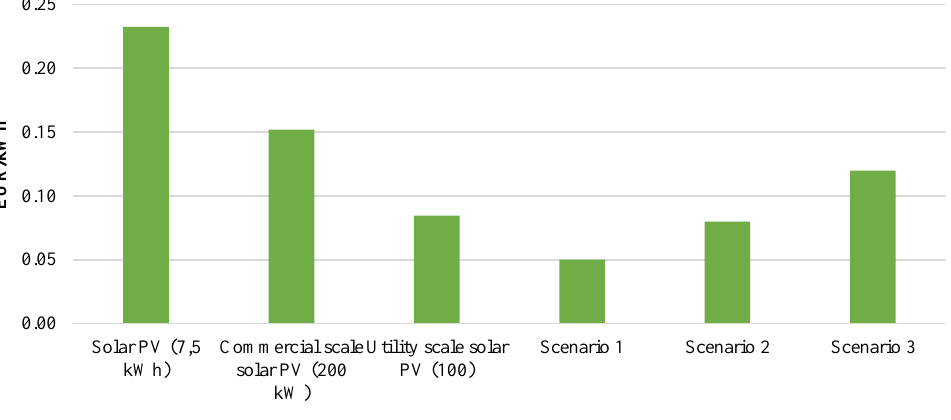
Fig. 7. Weighted average electricity price (LCOE) for renewable energy resources